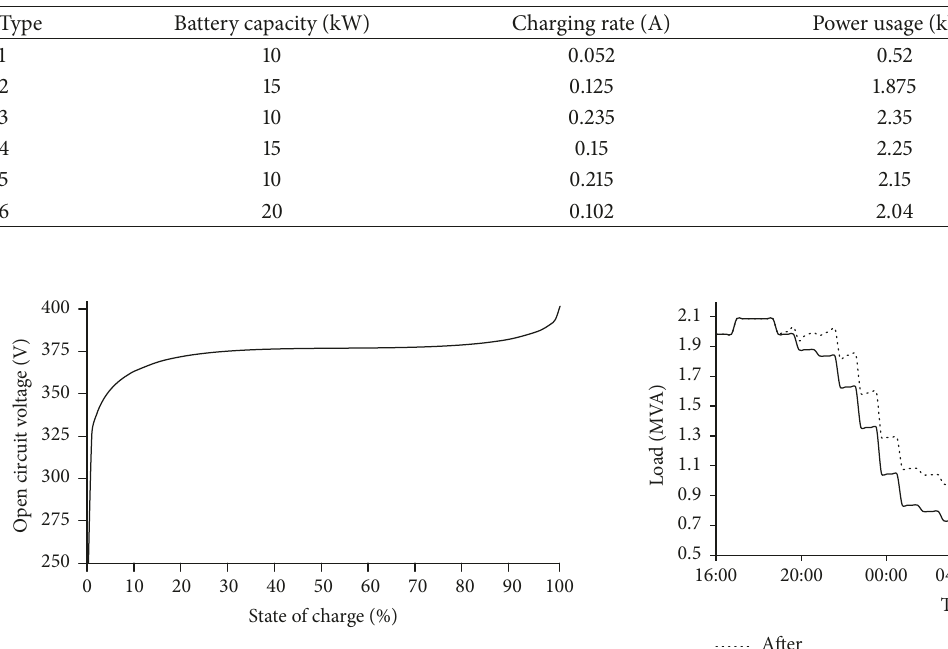
Figure 3: Relationship between open circuit voltage and SOC for LFP battery.